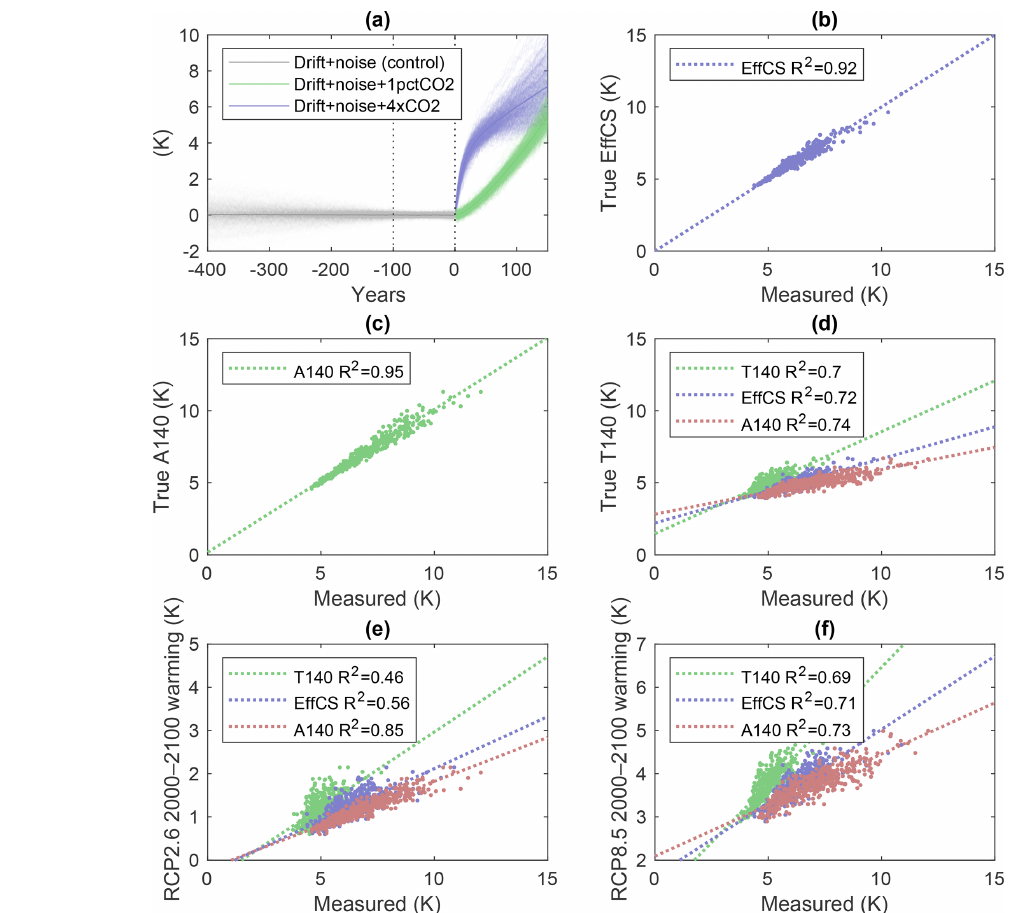
Figure 5. An idealized ensemble of simple models, where model parameters are identical to those considered in Fig. 1b, but models are initialized in a non-equilibrium state such that the baseline period is subject to some control drift, and model output is also subject to interannual variability of a similar magnitude to models in the CMIP archive. Panel (a) shows global mean temperature evolution for the control period (grey), abrupt4xCO2 simulation (blue) and 1pctCO2 simulation (green). Panels (b, c) show the true value of (EffCS, A140) as calculated in the noise-free, equilibrated simulations, plotted as a function of the measured value of (EffCS, A140) in a noisy, non-equilibrated simulation. Panels (d, f, g) show the true value of (T140, RCP2.6, RCP8.5 2000–2100 warming) plotted as a function of the measured values of T140, EffCS and A140,